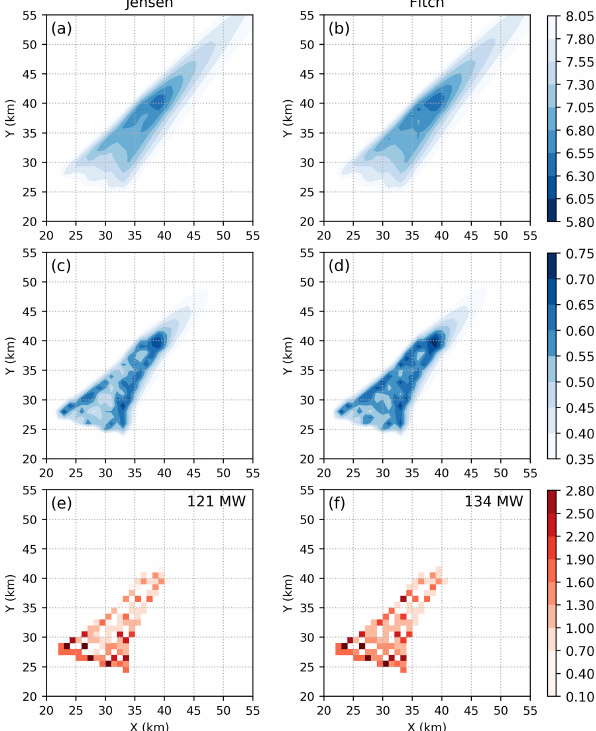
Figure 14. Same as Fig. 13 but at Anholt for wind direction of 168 ◦ . Note that the flow appears to be from the southeast, but in reality it is from 168 ◦ , and the wind farm is rotated